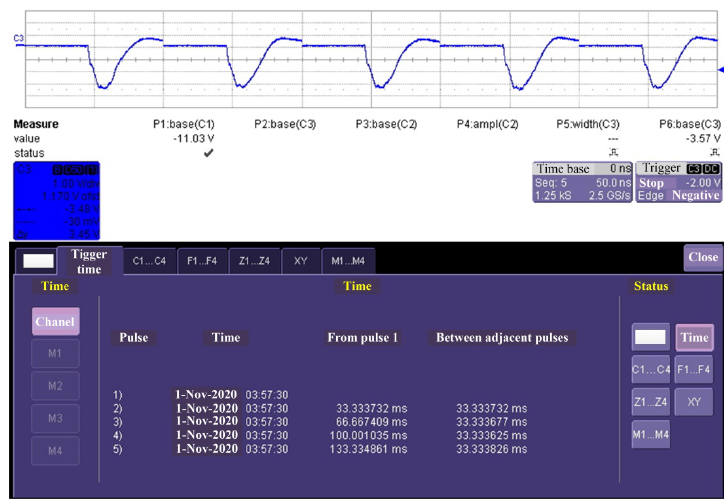
Figure 16. Screen shot of 5 pulses at 30 Hz operation.